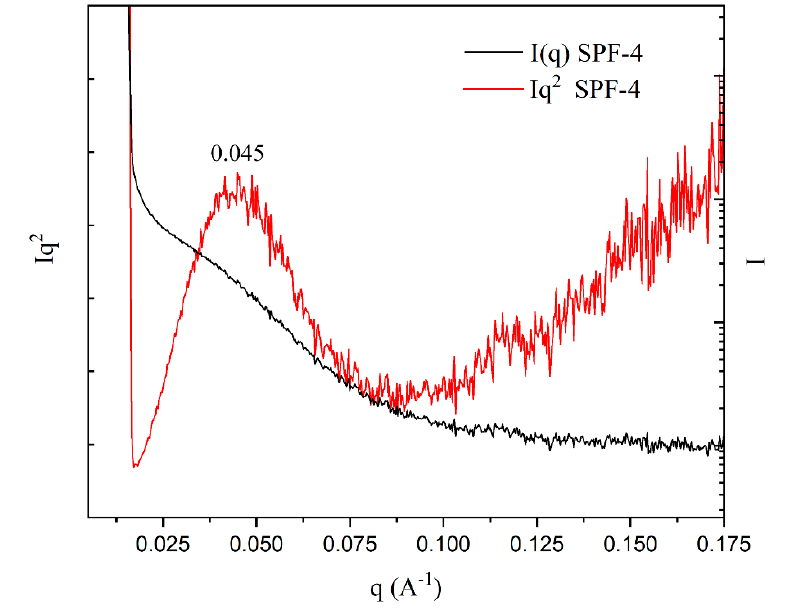
Figure 9. SAXS data for the cured SPF ‐ 4 resins.